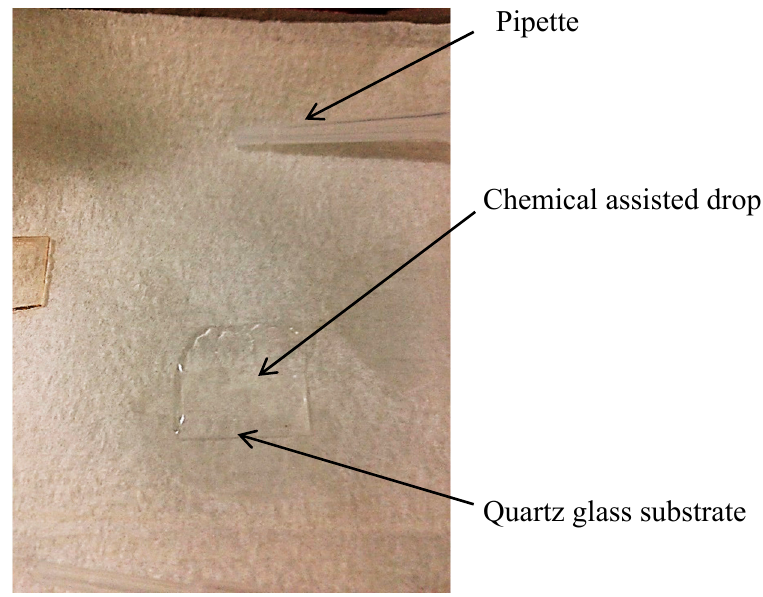
Figure 3. Dropping a chemical product on the quartz glass substrate by using a pipette. Crystals 2020 , 10 , x FOR PEER REVIEW